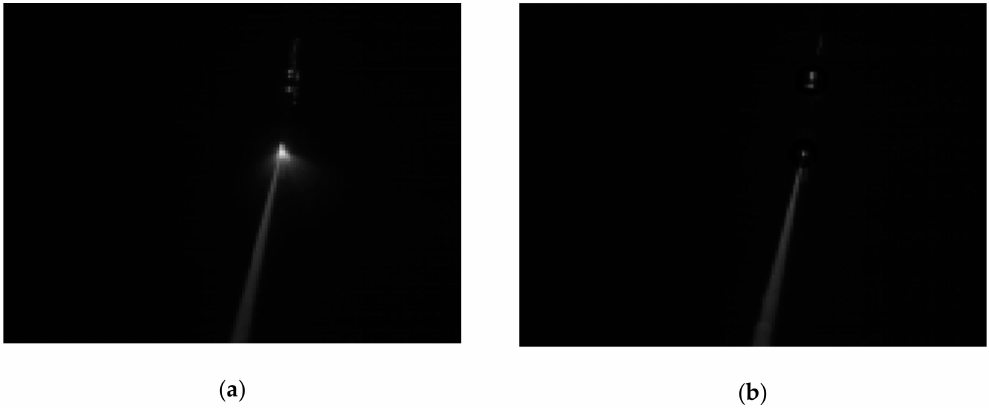
Figure 21. Images received by the CCD camera during the underwater reflective communication test: ( a ) high-level modulation image and ( b ) low-level modulation image.